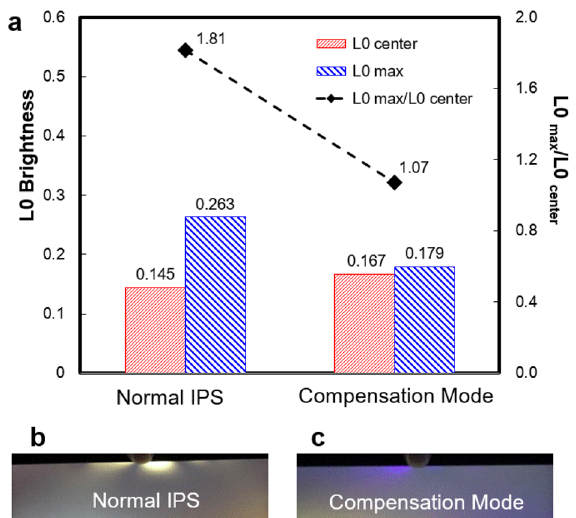
Figure 10. ( a ) The L0 brightness data. ( b ) and ( c ) The photos of LL when the samples are stressed.